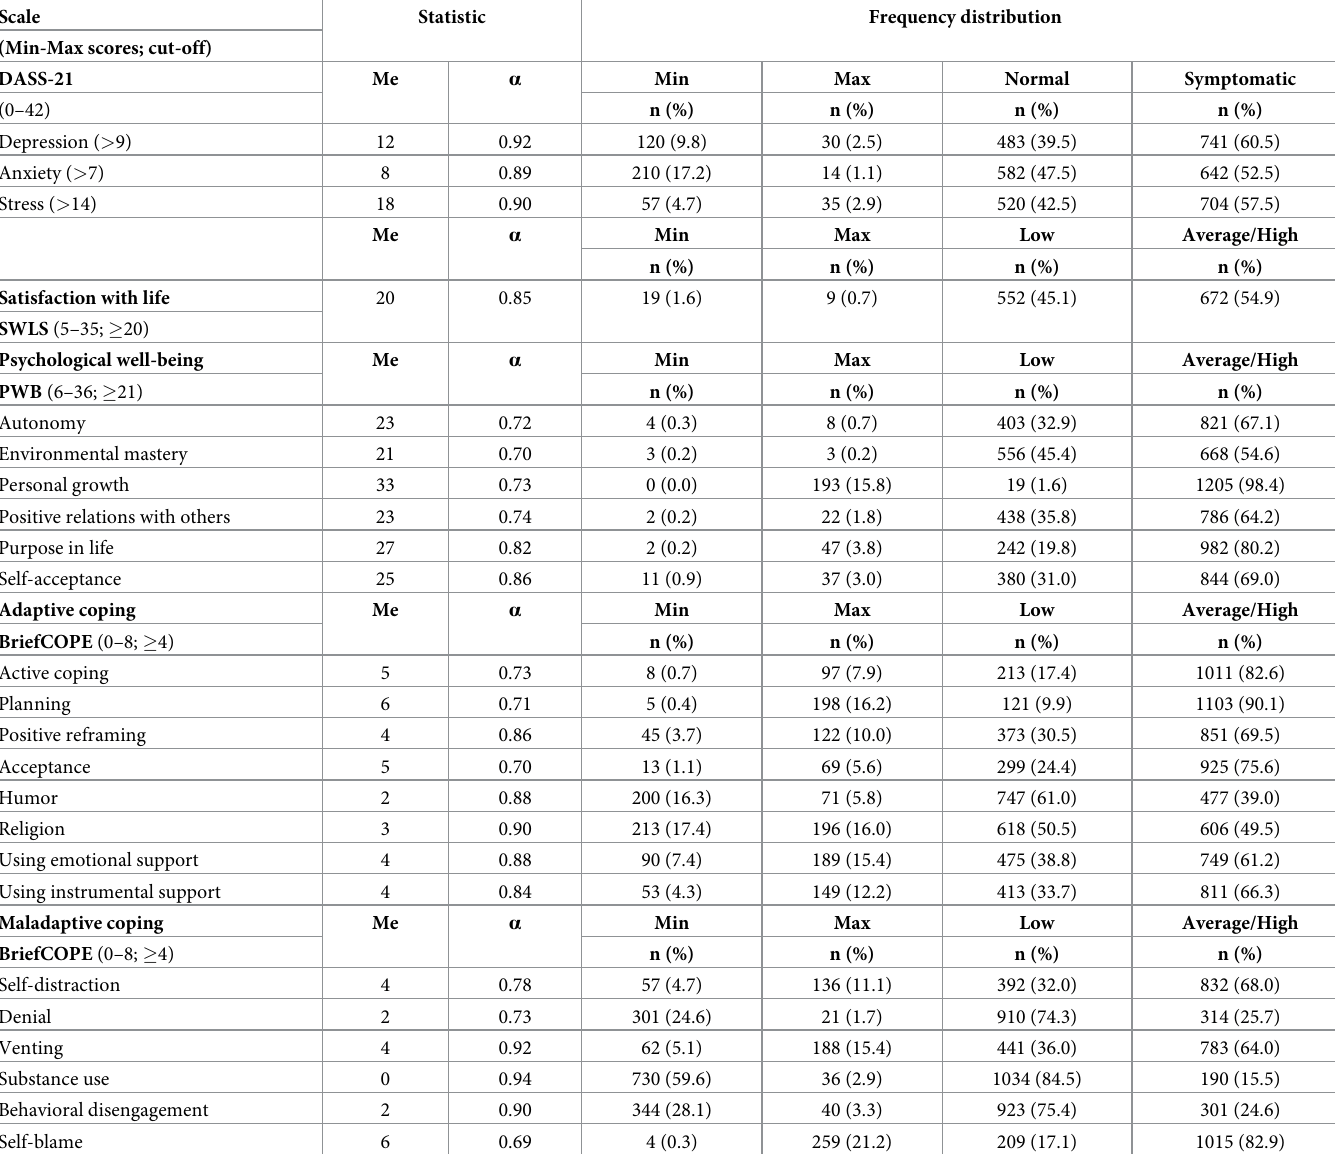
Table 2. Descriptive statistics and Cronbach’s alpha coefficient from the application of the DASS-21, SWLS, PWB and BriefCOPE scales in undergraduate students, Parana, Brazil,